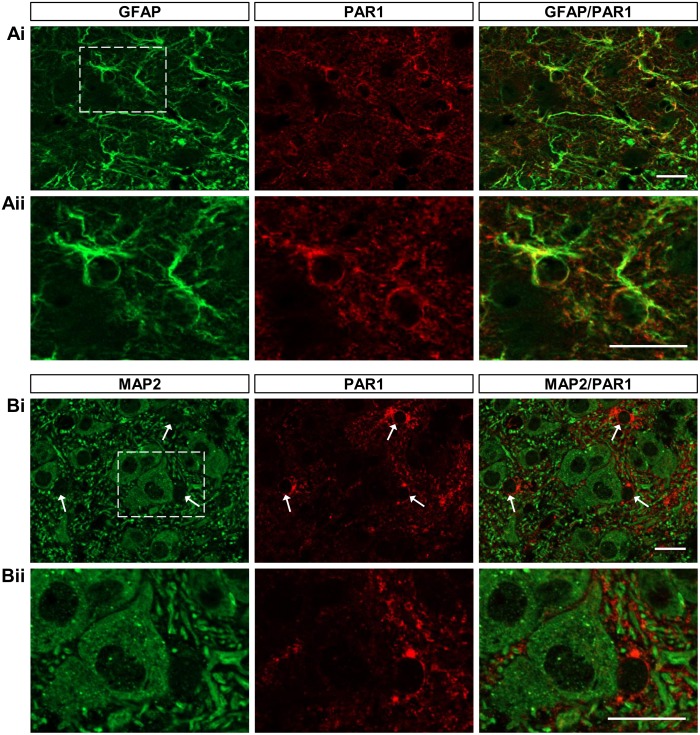
PAR1 immunoreactivity co-localises with GFAP but not with MAP2 in the lumbar ventral spinal cord.A: representative images showing 50 μm transverse sections taken from the upper lumbar spinal cord of a P6 C57BL/6 mouse. Sections were stained with antibodies raised against GFAP (green) and PAR1 (red). B: representative images showing 50 μm transverse sections taken from the upper lumbar spinal cord of a mouse. Sections were stained with antibodies raised against MAP2 (green) and PAR1 (red). Arrows in Bi indicate areas of PAR1 staining between MAP2+ cells. Scale bars: 20 μm.